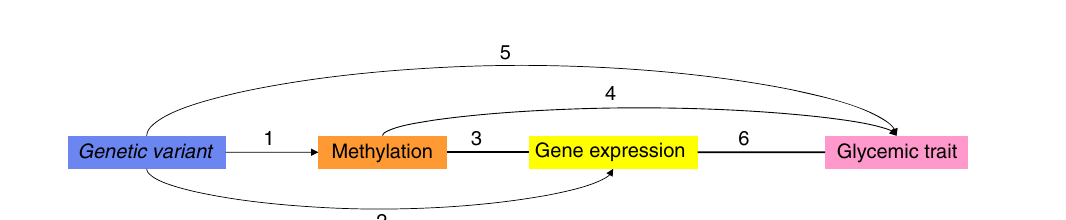
Fig. 1 Overview of the cross-omics analysis. (1) Methylation quantitative trait loci (meQTL). (2) Expression quantitative trait loci (eQTL). (3) Expression quantitative trait methylation (eQTM). (4) Epigenome-wide association study (EWAS) and Mendelian randomization (MR). (5) Genome-wide association study (GWAS). (6) The association of gene expression expressed in the glucose or insulin metabolism-related tissues and glycemic traits. Results in 1, 2, 3 were extracted from the summary statistics from Biobank-based Integrative Omics Study (BIOS) database ( n = 3814). Results in 4 was the results in